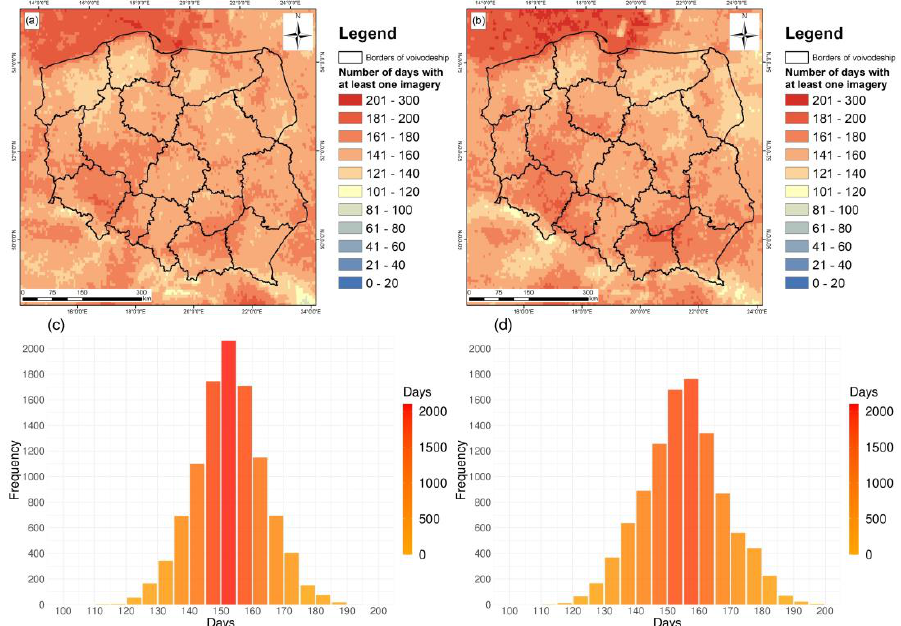
Figure 2. Days when at least one S5-P image with a qa_value > 0.75 and cloud fraction < 0.50 (further: